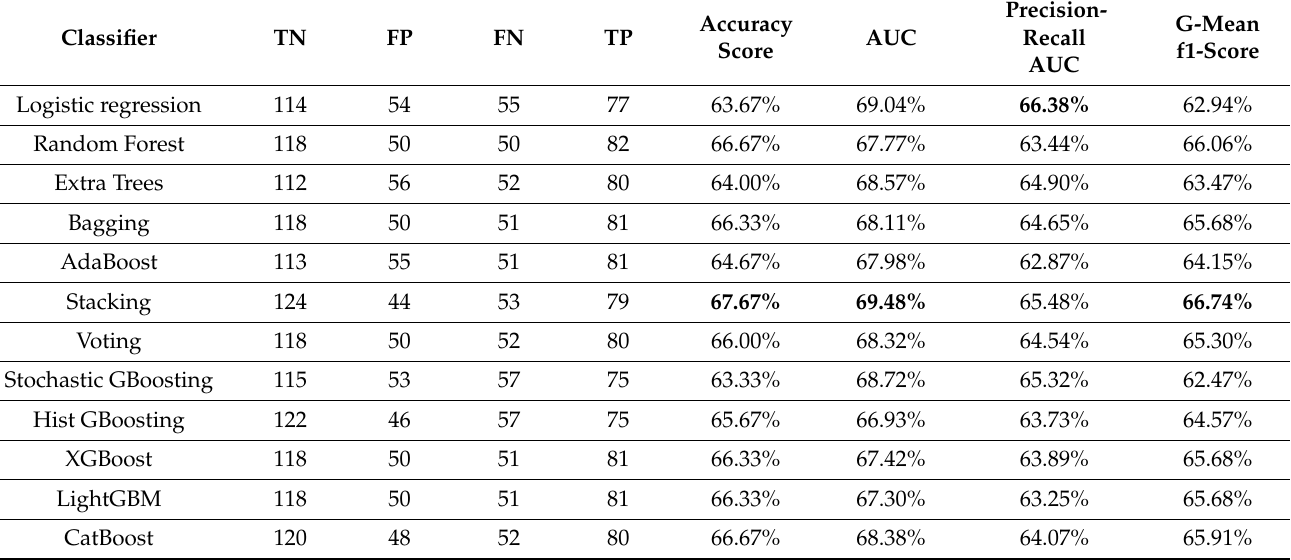
Table 7. Summary result.